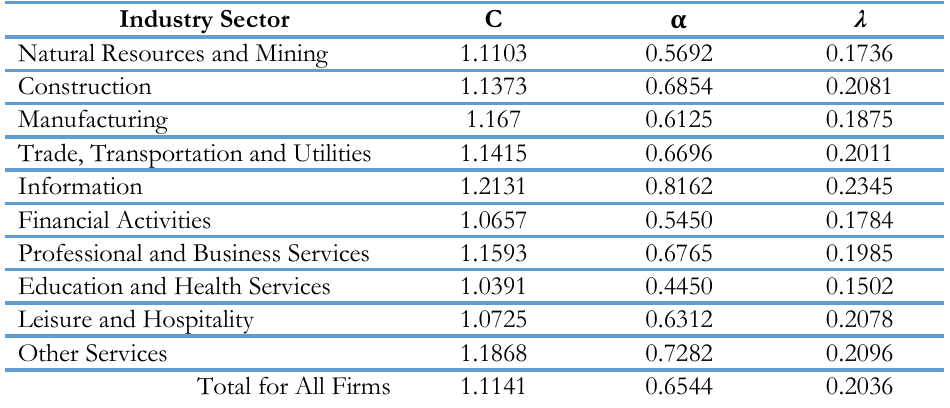
Table 2: Parameters that define exponential and power functions- transition point at time t = 3 Power and Exponential Functions Parameters